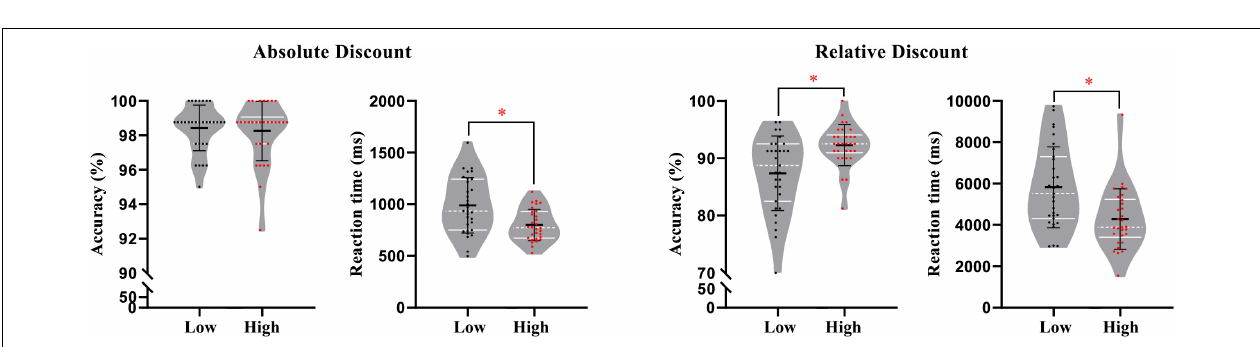
FIGURE 3 | Behavioral performance in two promotion frameworks. White lines were quartile of data; black lines were mean and standard deviation of data; each colored dot represented raw data of a subject. * p < 0.05 (the same